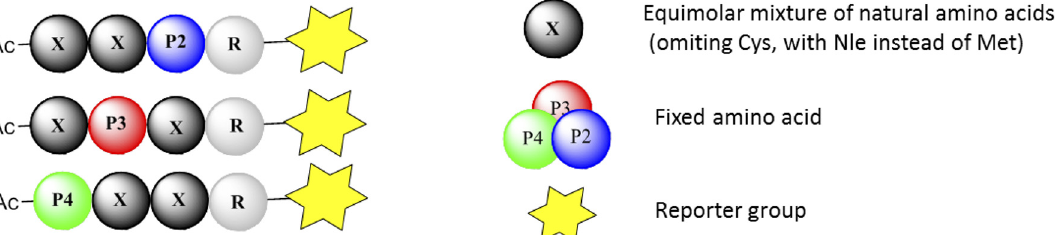
Fig 1. Scheme of the HyCoSuL P1 Arg library. The general library structure contains tetrapeptide derivatives with the sequence Ac-P4-X-X-Arg-ACC, Ac- X-P3-X-Arg-ACC, Ac-X-X-P2-Arg-ACC, where P4, P3 and P2 represents one of 120 fixed natural or unnatural amino acids and X represents an equimolar mixture of natural amino acids (omitting Cys and substituting Nle for Met) with ACC (7-amino-4-carbamoylmethylcoumarin) as a reporter group.